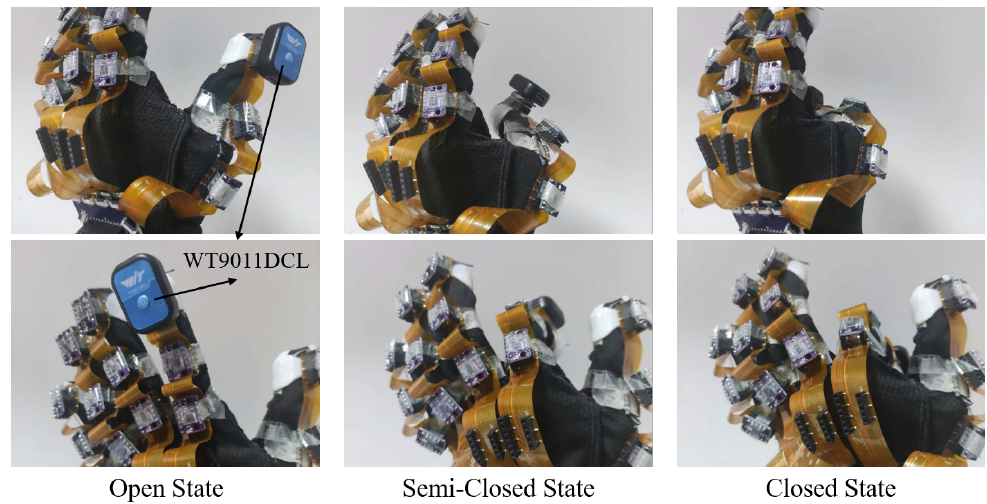
Figure 9. Open state, semi-closed state, and closed states for static tests. Table 1. The mean absolute error (MAE) of the static tests for the index finger IMU1 during fif- teen minutes.